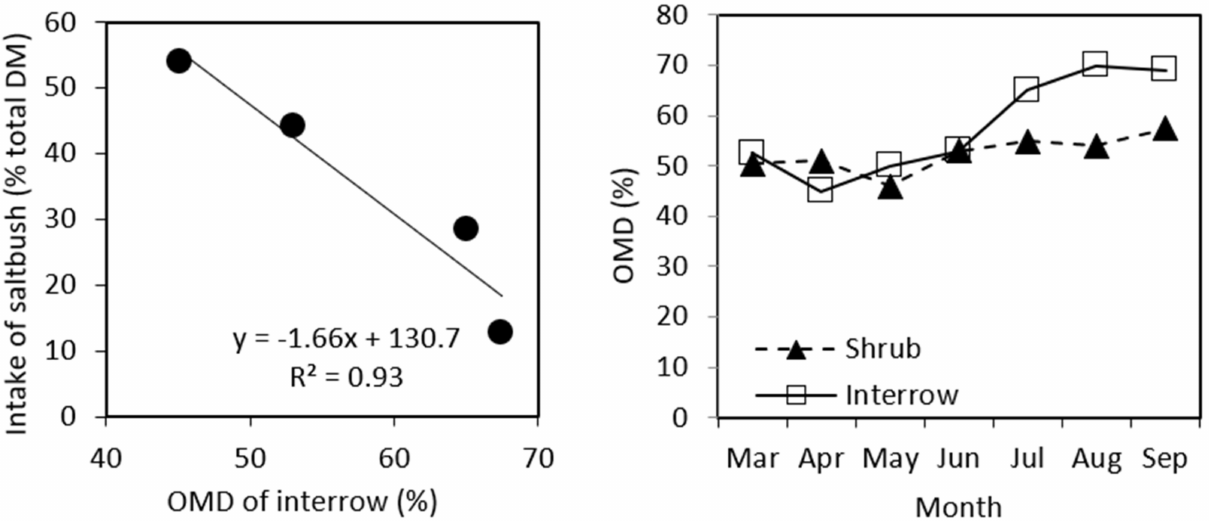
Figure 3. ( Left ) Saltbush removed as proportion of total diet (DM basis) based on organic matter digestibility (OMD) of the understorey/interrow, ( right ) OMD of the edible saltbush (solid triangle, segmented line) remains relatively constant throughout the year compared to the interrow (open square, solid line) reproduced from